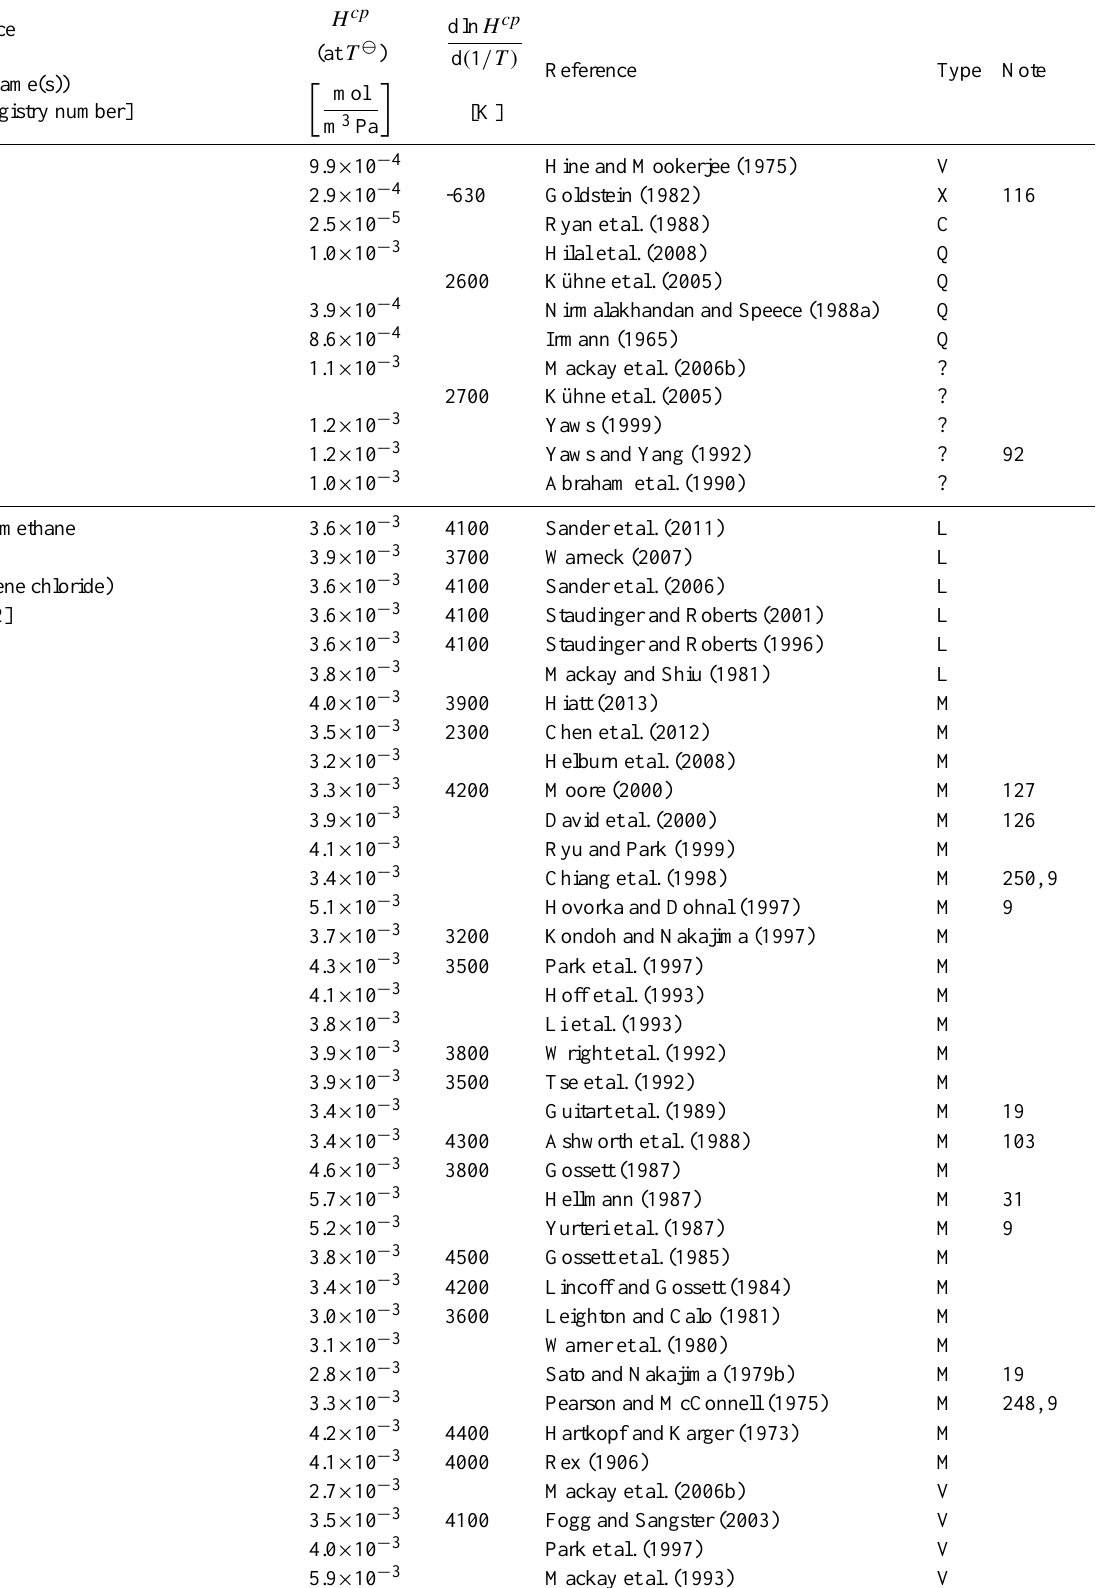
Table 6: Henry’s law constants for water as solvent